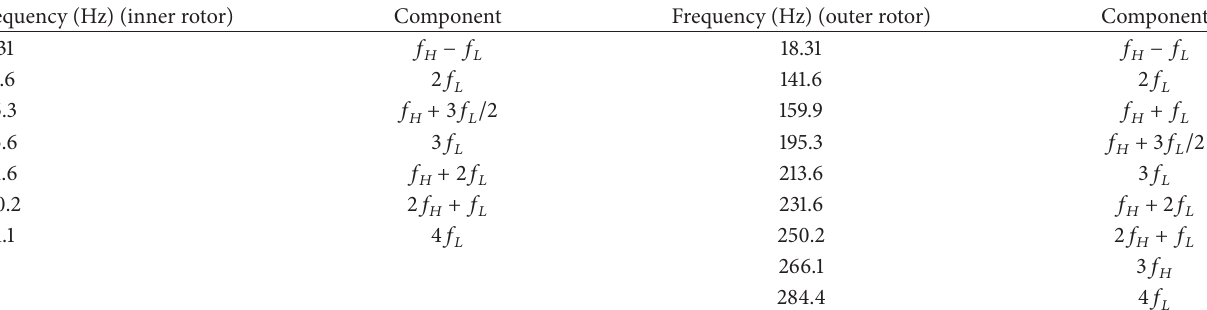
Table 2: The vibration frequency spectrum component analysis of inner and outer